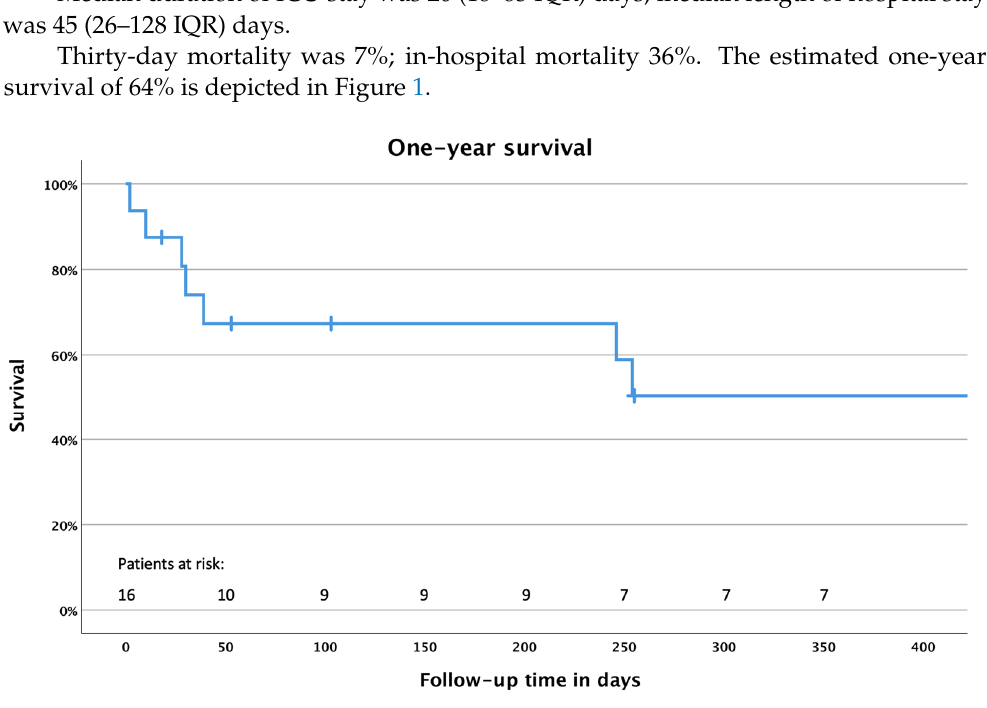
Figure 1. Kaplan-Meier analysis of the 1-year survival.